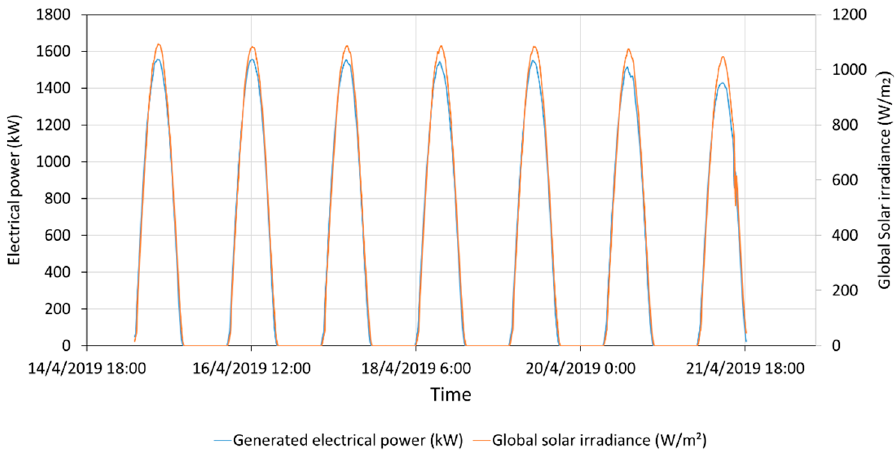
Figure 10. The power generation and the global solar irradiation in the period between 15 April and 21 April 2019. 2019 and 21 April 2019.